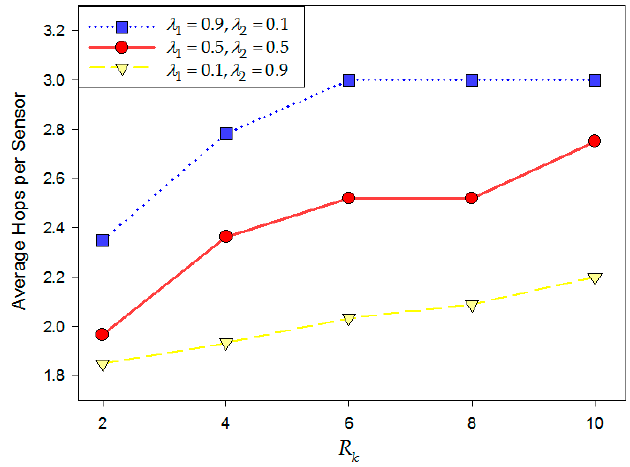
Figure 18. Average hops of each sensor versus R k .